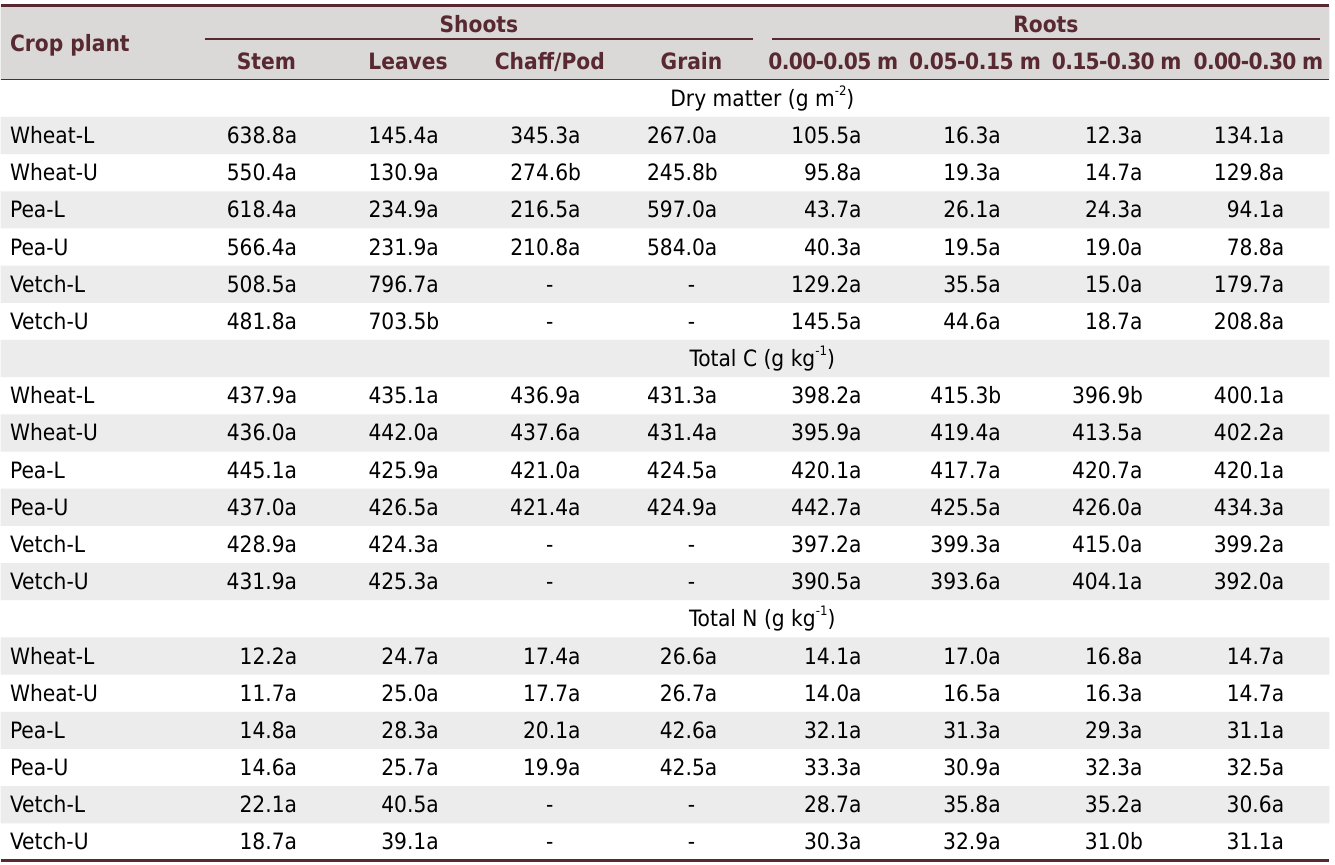
Wheat-L: wheat labeled; Wheat-U: wheat unlabeled; Pea-L: pea labeled; Pea-U: pea unlabeled; Vetch-L: vetch labeled; Vetch-U: vetch unlabeled. -: not determined. The values are the means of three replicates. Means followed by different lowercase letters within a column represent significant differences at p<0.05 between labeled and unlabeled plants for a given